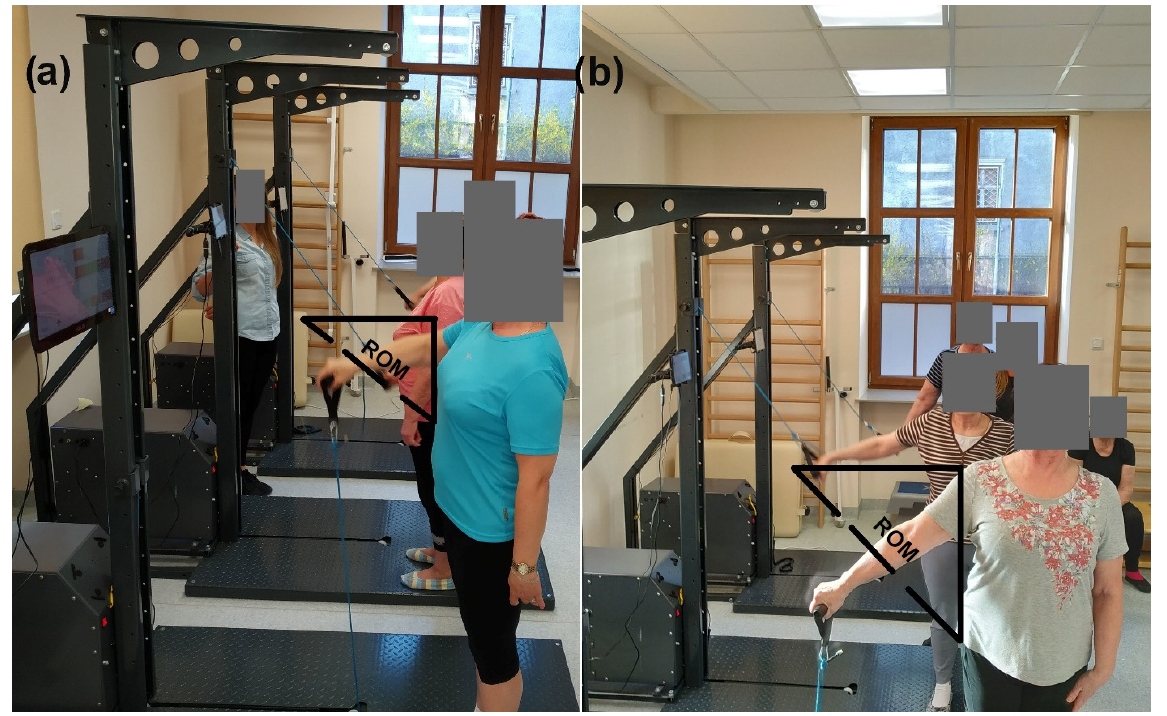
Figure 1. Subject positions during strength testing and training. The subjects’ positions ( a ) during flexion (first person) and during extension (second person); ( b ) during abduction (first person) and during adduction (second person). ROM—range of motion during flexion and extension ( a ) and during abduction and adduction ( b ). Table 1. Treatment applied in training group (T) and control group